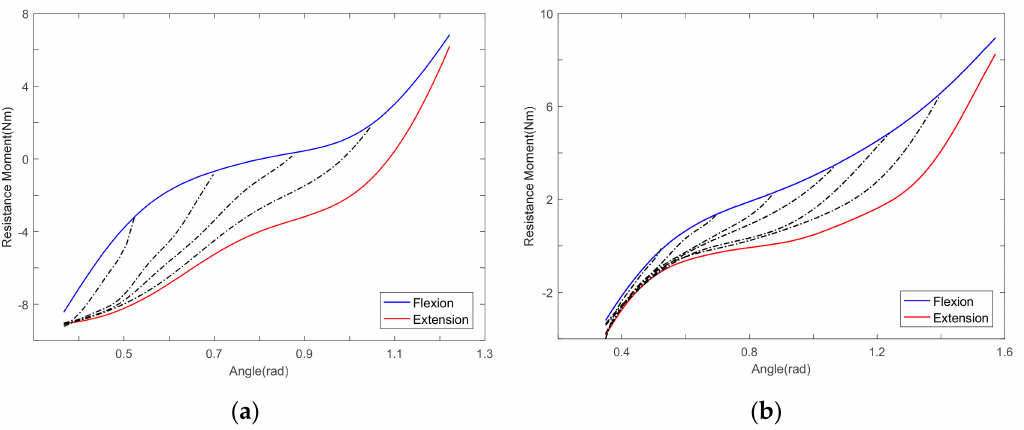
Figure 3. The resistance moment of upper limb joints: ( a ) shoulder joint; ( b ) elbow joint.